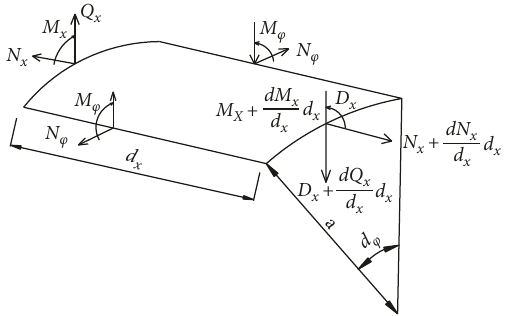
Figure 5: Internal force of the